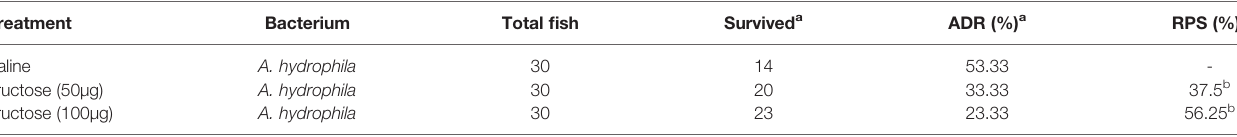
TABLE 1 | Immune protection of fructose to A. hydrophila infection in crucian carp.